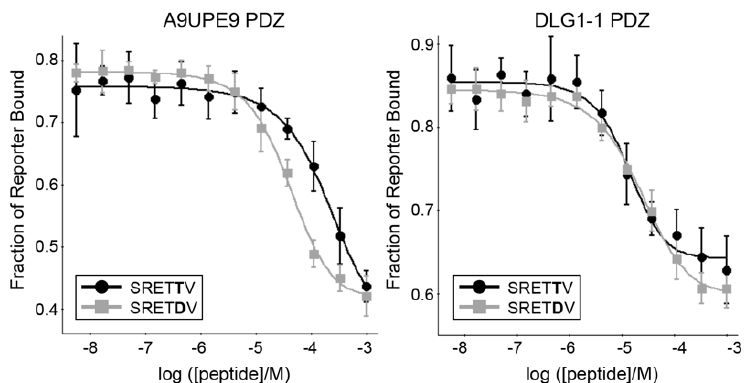
Figure 6. The binding isotherms from competition fluorescence polarization experiments of A9UPE9 ( left , as labeled), and DLG1-1 ( right , as labeled) PDZ domains are shown with the HPV18 E6 variant peptides SRETTV and SRETDV. The average values are shown, with error bars representing standard deviation from at least triplicate experiments. K I values were determined using SOLVER, as previously described [12,45,46,48,54,60]. Table 3. Binding affinities for the A9UPE9 and DLG1-1 PDZ domains, determined by fluorescence polarization experiments. For all, F*- HPV18 E6 was used as a reporter peptide, and values reflect at least triplicate experiments. Differences as compared with HPV18 E6 are underlined, as relevant. Lines indicate related clusters of peptides: HPV sequences, HPV18 E6 variant sequences, SNX27/SHANK1/GIPC targets, and mbSHANK M. brevicollis targets, respectively. K I Values ( M) Peptide